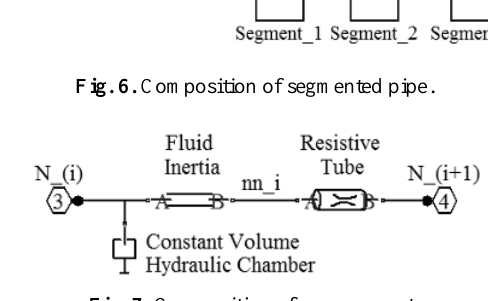
Fig. 7. Composition of one segment